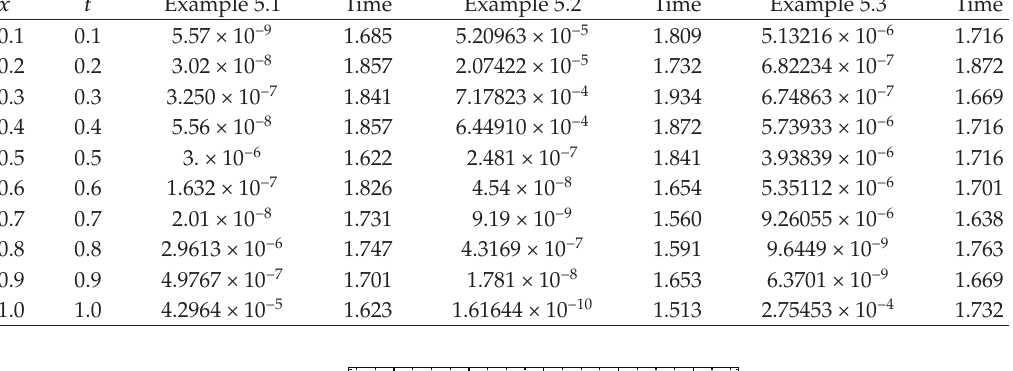
Table 7: The relative errors and computational times for Examples 4.1–4.3 at di ff erent values of x and t .